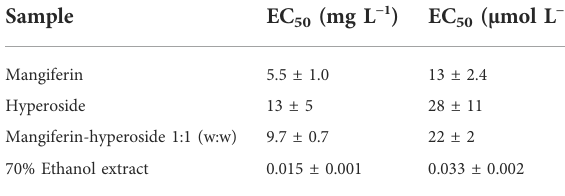
additive concentration of both